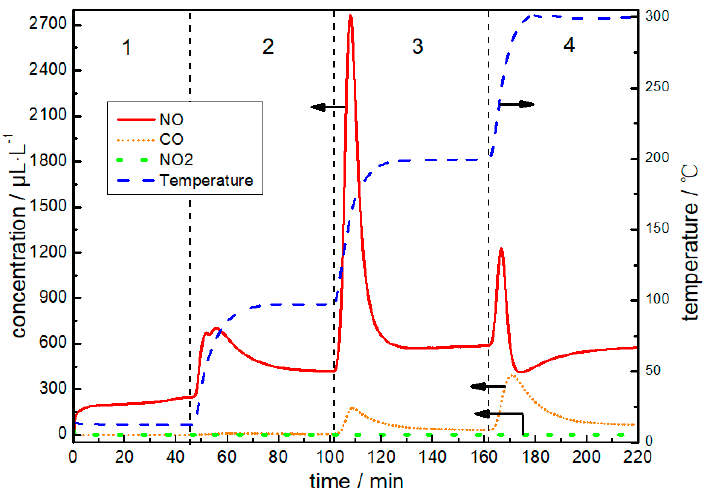
Figure 5. Effect of AC on NO 2. Figure 5. E ff ect of AC on NO 2 .